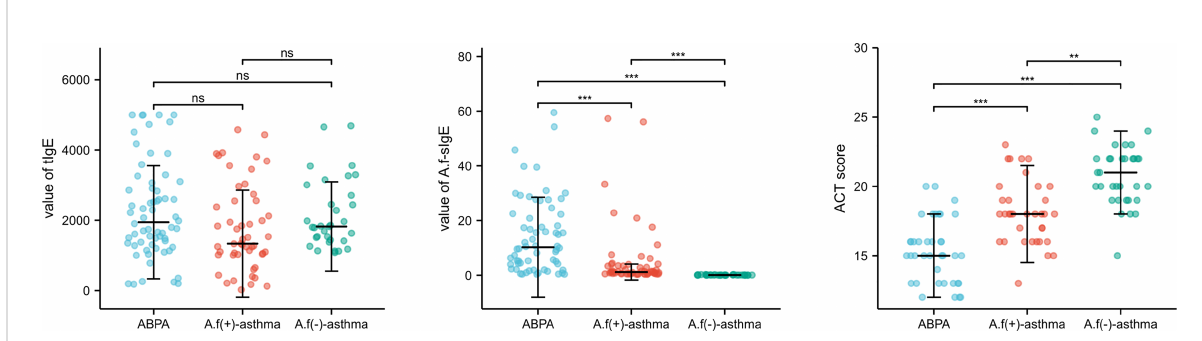
FIGURE 1 The comparison of tIgE, A.f -sIgE, and ACT score in three groups. ABPA, allergic bronchopulmonary aspergillosis; A.f (+) asthma, Aspergillus fumigatus -sensitized asthma; A.f ( − ) asthma, non- Aspergillus fumigatus sensitized asthma. ns, no signi fi cance; **p<0.01; ***p<0.001.